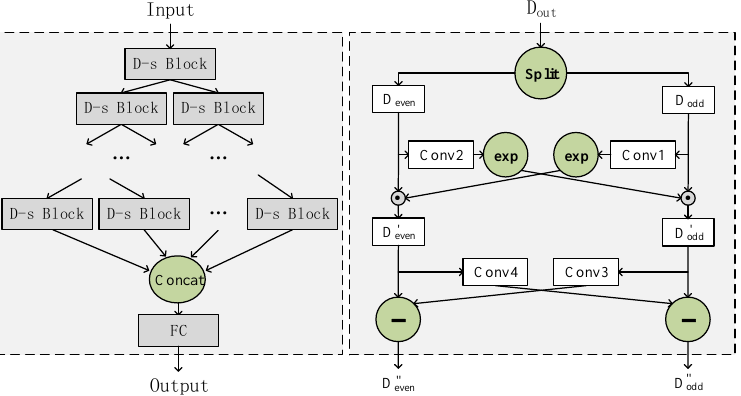
Figure 2. Down-sampling Convolution Module and Down-sampling block (D-s